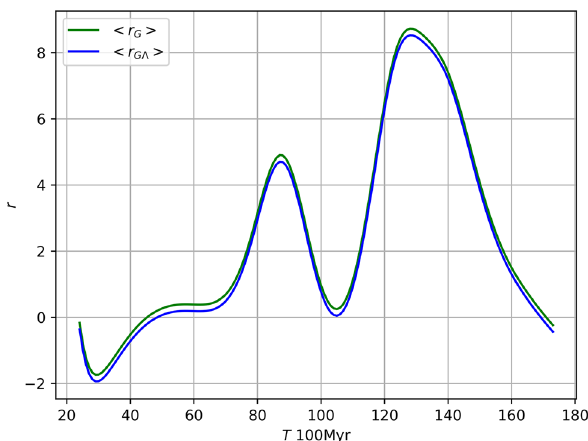
Fig. 1 The Ricci curvature variation vs cosmological time for galaxy cluster parameters in Newtonian (green) and Λ -modified gravity (blue)